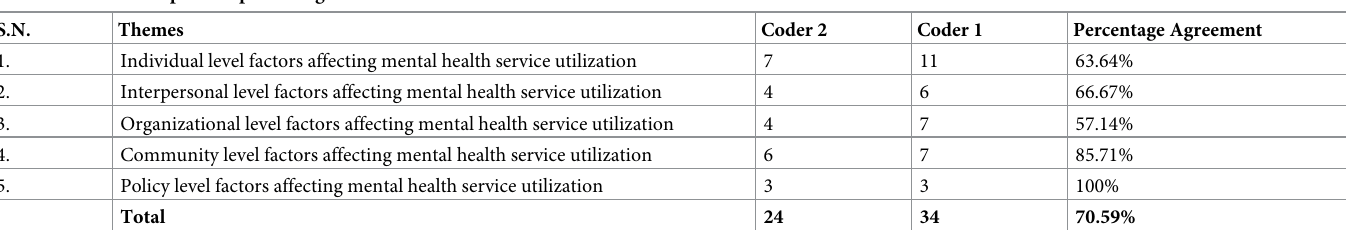
Table 1. Inter-coder positive percent agreement.